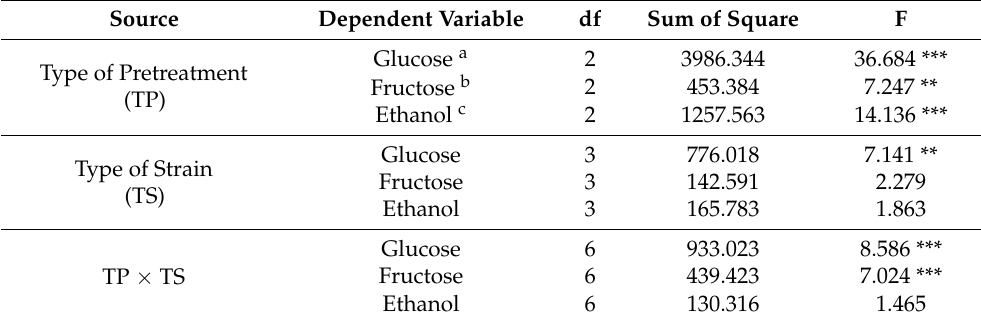
Table 2. Effect of different variables (type of pretreatment—TP, type of strain—TS and their interac- tion) on glucose and fructose consumption and ethanol production.